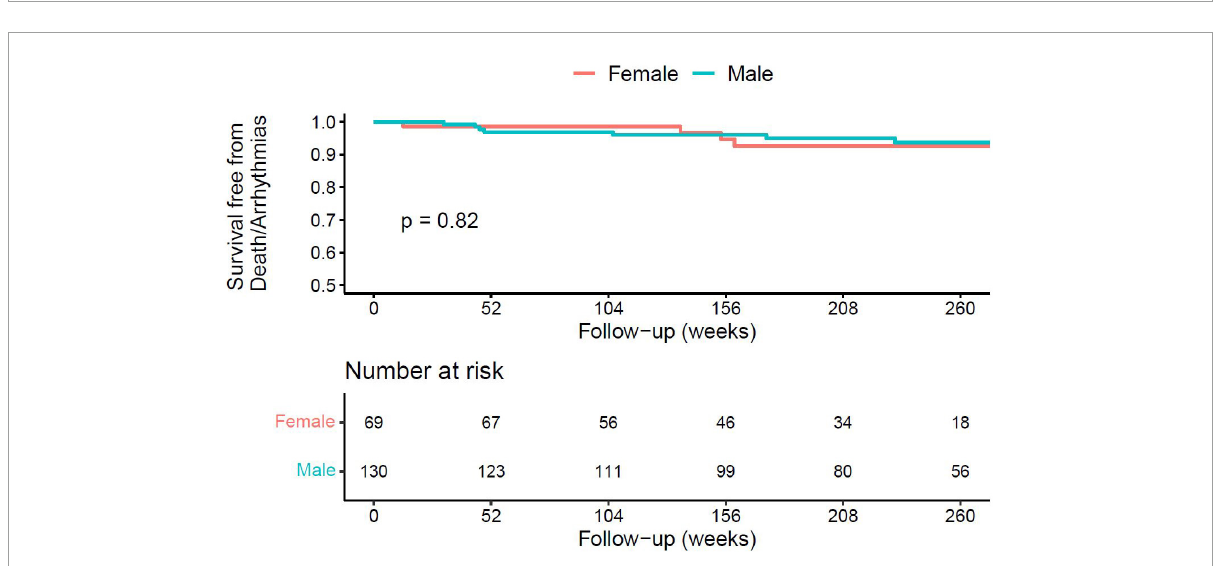
FIGURE2 Kaplan–Meier curve for all-cause mortality, resuscitated cardiac arrest, and appropriate implantable cardioverter defibrillator (ICD) therapy following hospital discharge in patients with AM, according to